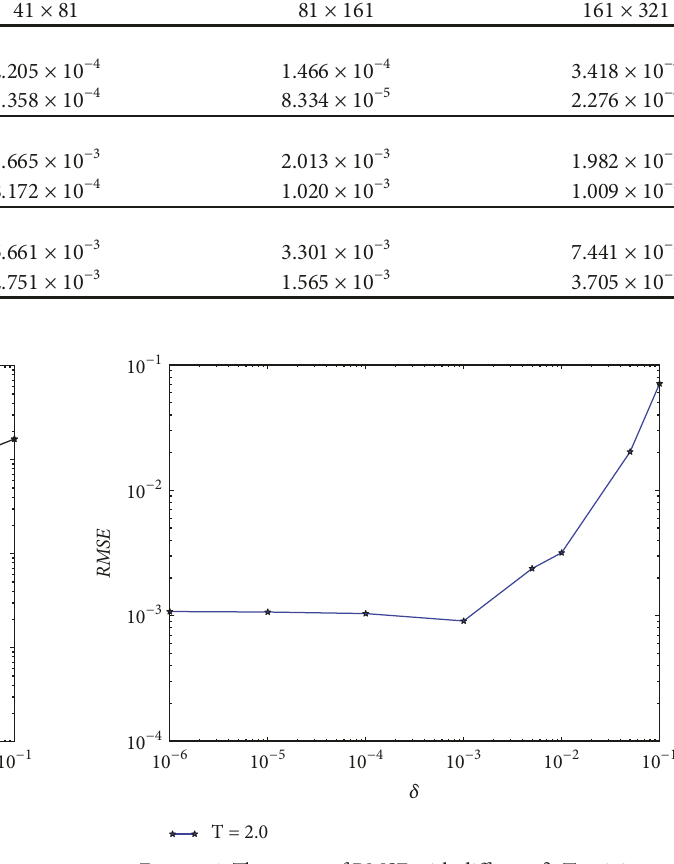
Figure 3: The errors of RMSE with different 𝛿 , 𝑇 = 1.0 . Figure 4: The errors of RMSE with different 𝛿 , 𝑇 = 2.0